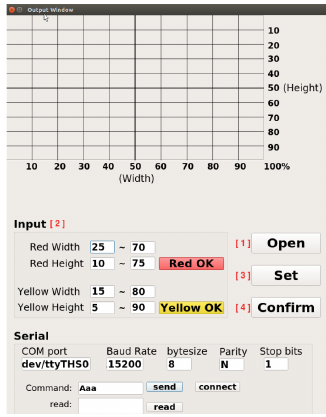
Figure 10. User interface for communication and input warning range functions.